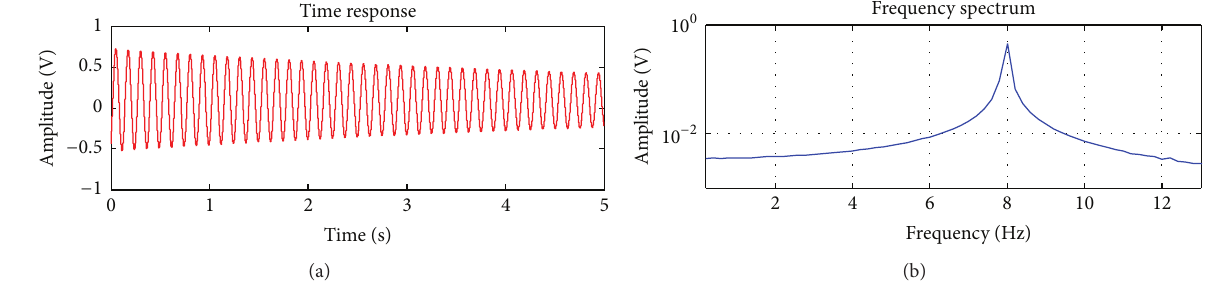
Figure 6: Transient response of the primary structure with a tip impact and without absorber. (a) Time history of the primary structure; (b) frequency spectrum of the response.